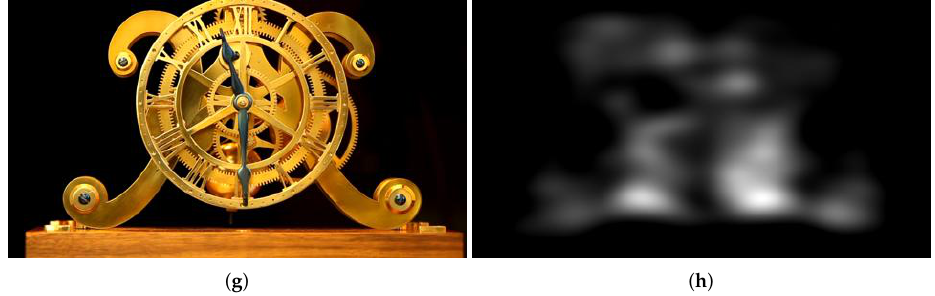
Figure 3. Illustration of saliency map extraction: ( a , c , e , g ) input video frames and ( b , d , f , h ) saliency maps of the input video frames obtained by the method of Li et al.